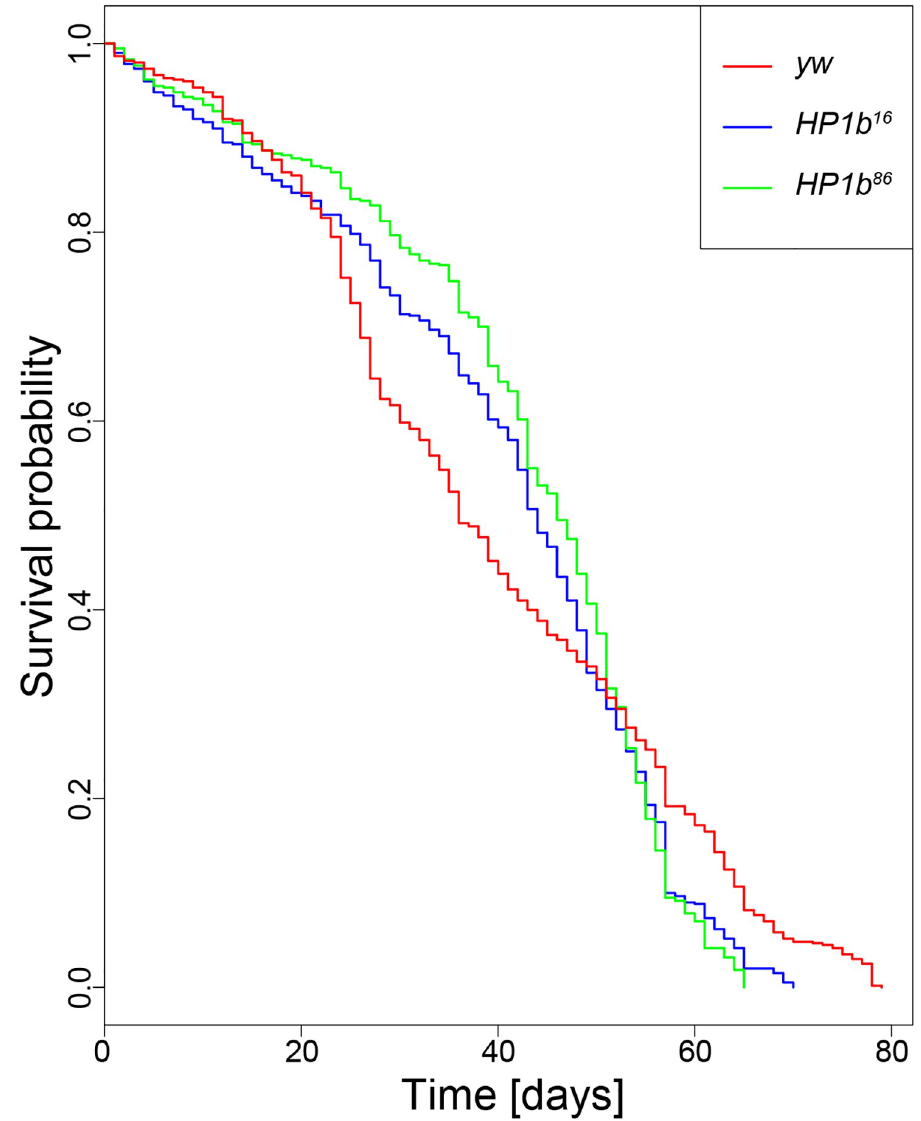
Fig 6. Loss of HP1B impacts survival. Survival curves differ significantly between the HP1b mutant strains and the yw control strain (p = 0.0483; log rank test). X-axis: Time to death in days. Y-axis: Survival probability. Data shown are combined from three trials, each with 100 animals per genotype/sex. For separate survival curves for males and females, see S4